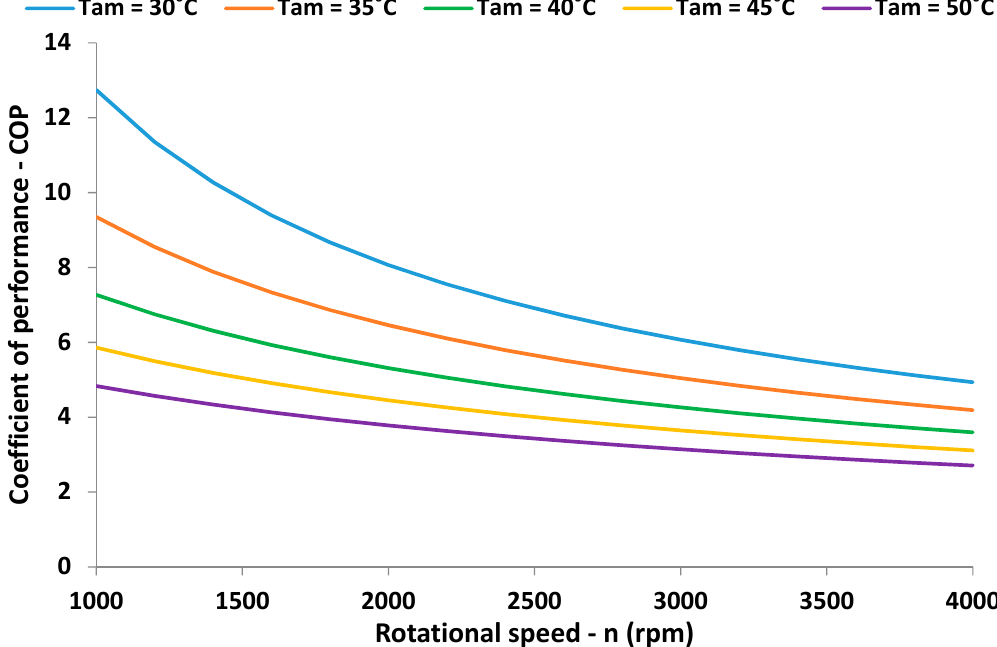
Figure 2. Coefficient of performance for different rotational speeds and ambient temperatures ( T ind = 25 °C).